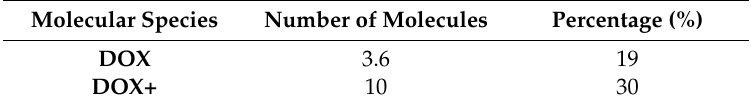
Table 3. Average number and degree of penetration of drug molecules within the membrane’s structure.